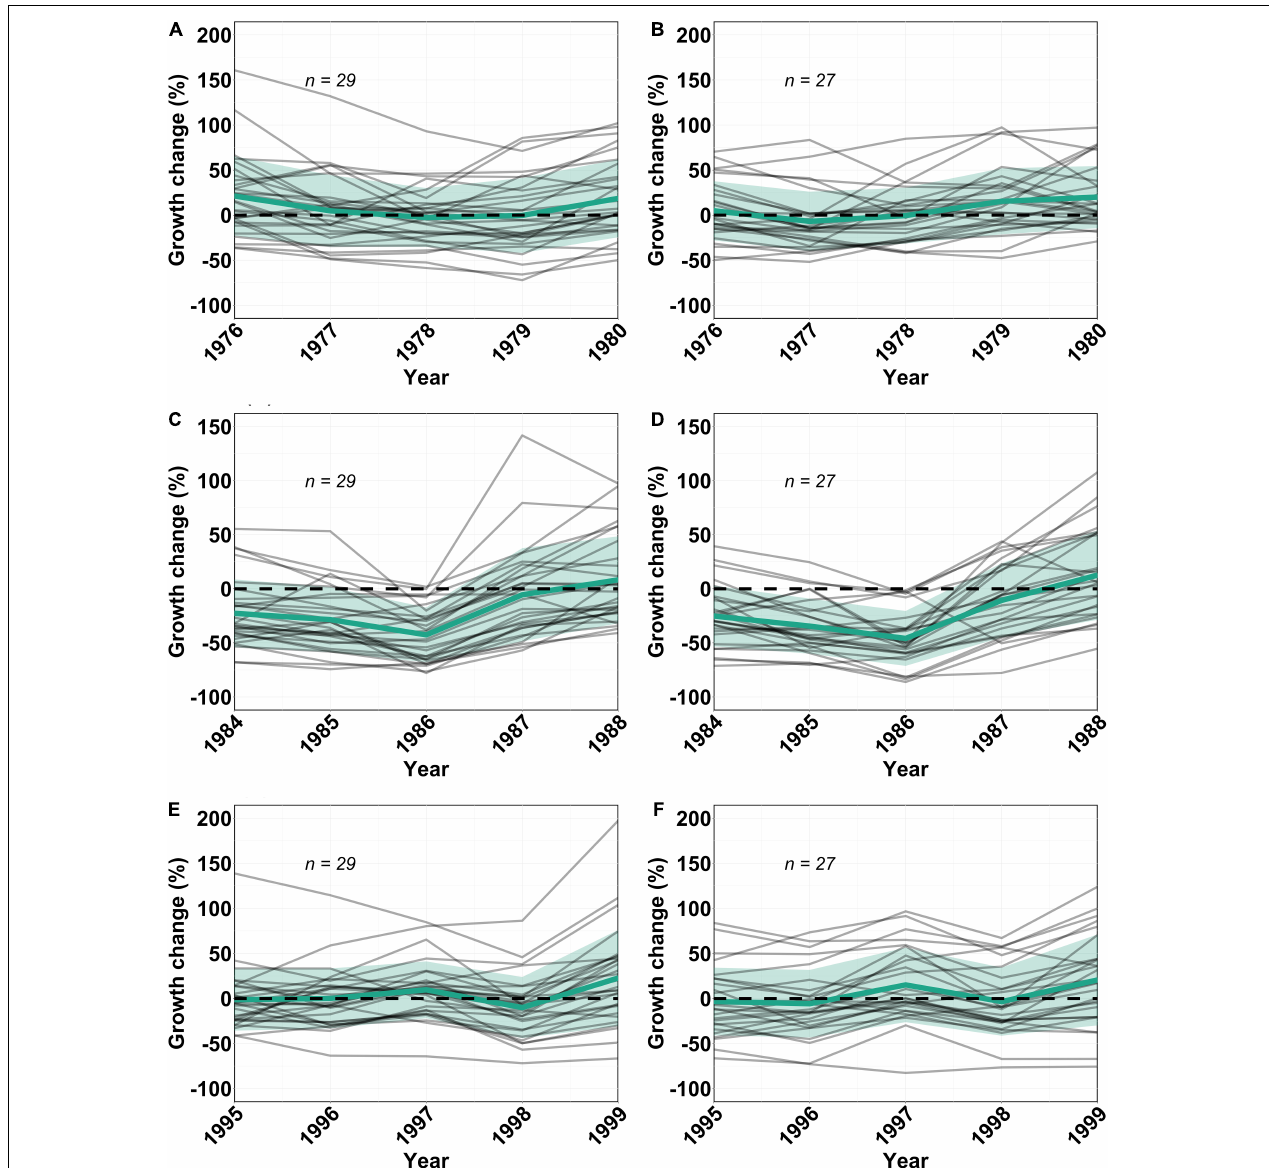
FIGURE 2 | Individual tree (gray lines) and mean (solid green lines) ± 1 SD (green shaded areas) percentage growth change across all trees at a given density relative to BAI1976 con , BAI1984 con or BAI1995 con values for the 1976 (A,B) , 1984 (C,D), and 1995 (E,F) droughts, respectively, calculated annually for both high density ( ρ H – A,C,E ; n = 29 ) and low density ( ρ L – B,D,F ; n = 27 ) stands. The horizontal black dashed lines indicate no detectable difference between a given year’s growth and BAI con (growth rates recovered to climatically constrained pre-drought average